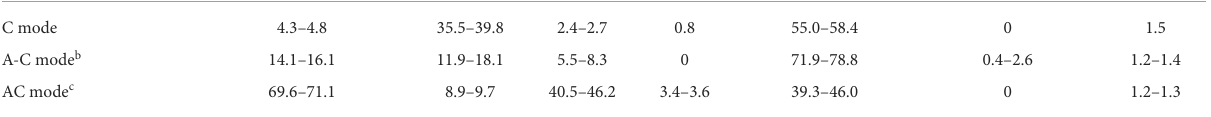
TABLE 3 Carbonation yields and phase proportions for the carbonated slag in C, A-C, and AC modes.